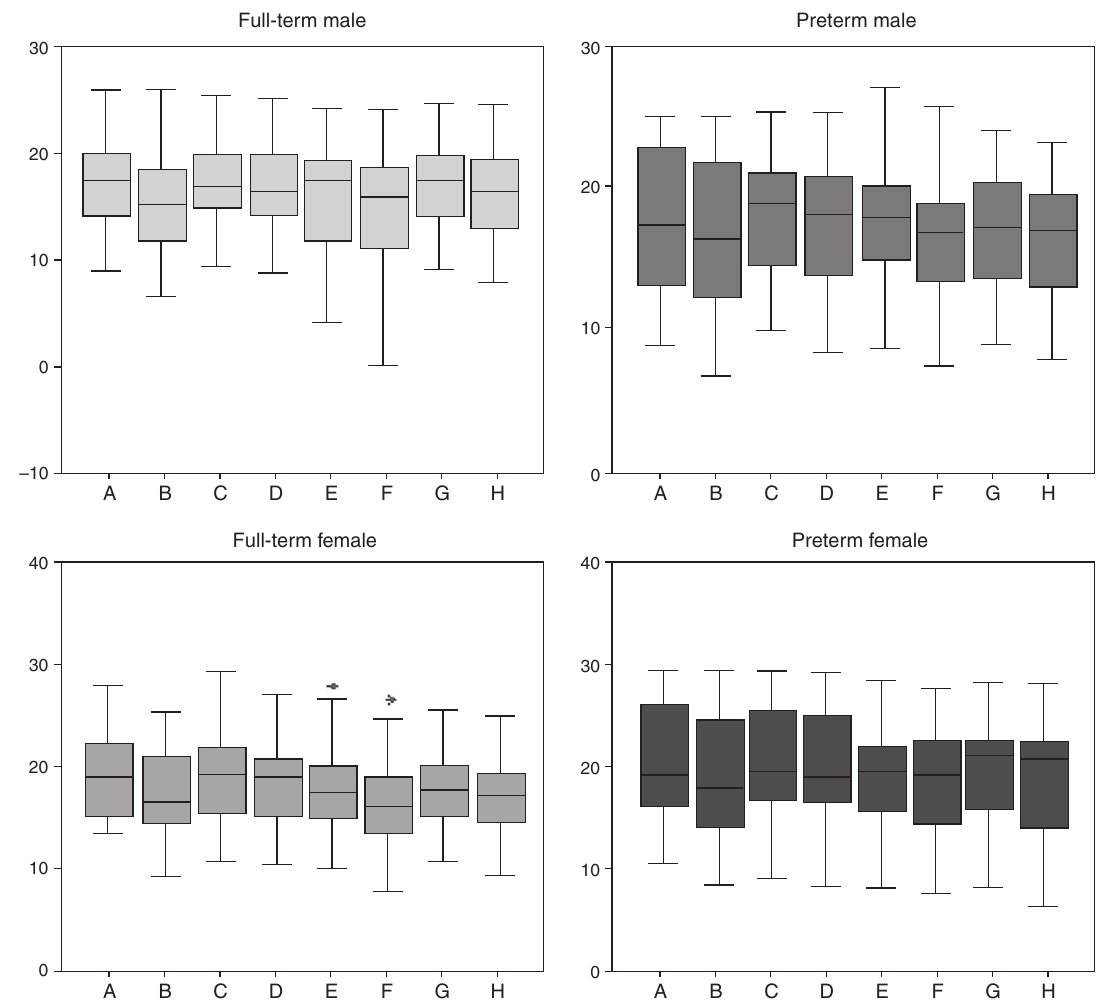
Response levels of transient evoked otoacoustic emissions (TEOAE; dB SPL) for linear and non-linear click-evoked stimulus presented at 60 dB SPL, by gender, ear, and presence of contralateral noise, for full-term and preterm groups. (A) Right ear nonlinear click-evoked stimulus with contralateral noise; (B) right ear nonlinear click-evoked stimulus without contralateral noise; (C) right ear linear click-evoked stimulus with contralateral noise; (D) right ear linear click-evoked stimulus without contralateral noise; (E) left ear nonlinear click-evoked stimulus with contralateral noise; (F) left ear nonlinear click-evoked stimulus without contralateral noise; (G) left ear linear click-evoked stimulus with contralateral noise; (H) left ear linear click-evoked stimulus without contralateral noise. Comparison between right and left ear with no difference ( p > 0.05); Comparison between genres: amplitude for linear click-evoked stimulus stronger for female gender ( p <